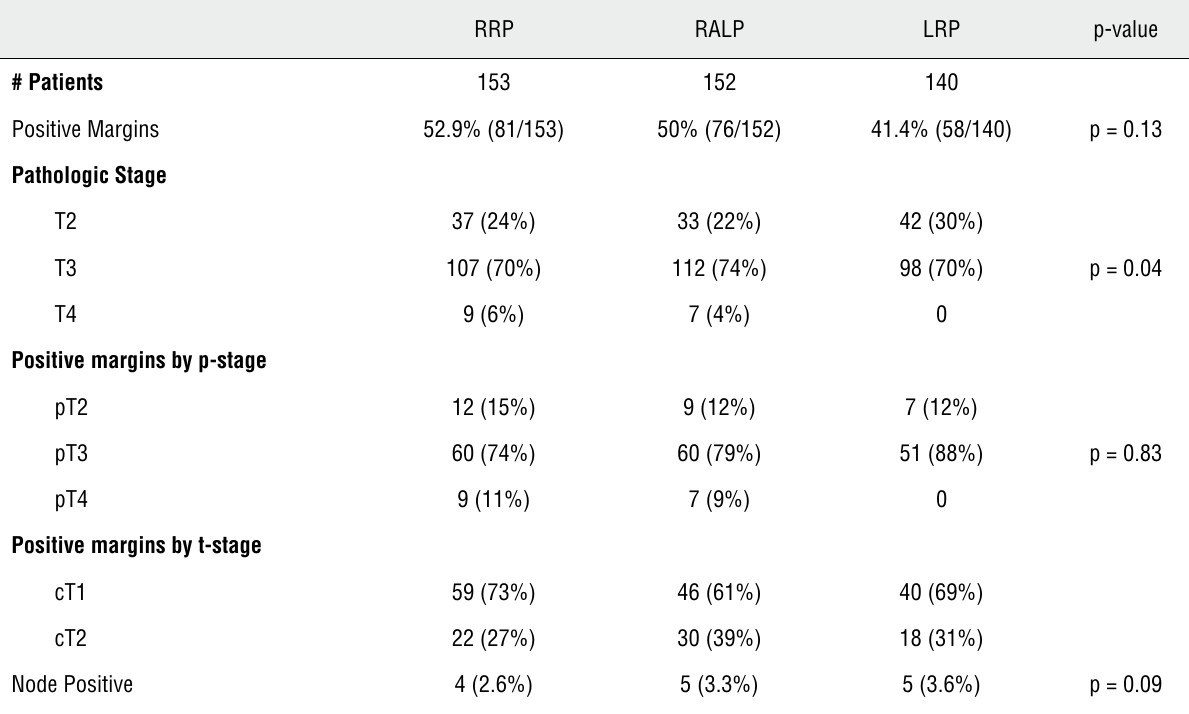
Table 2 - Pathologic